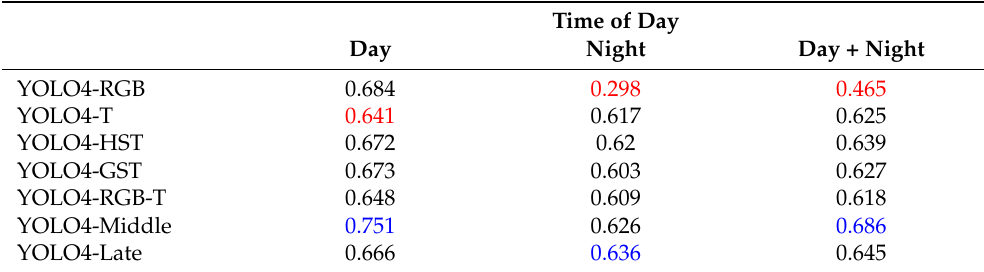
Figure 7. The obtained plot of recall and number of false positives depending on the chosen IoU threshold for YOLO4-Middle. Table 2. The obtained mean average precision mAP 50 metric for different types of pedestrian detection systems depending on the time of day. The best result for the selected time of the day is marked in blue, and the worst is